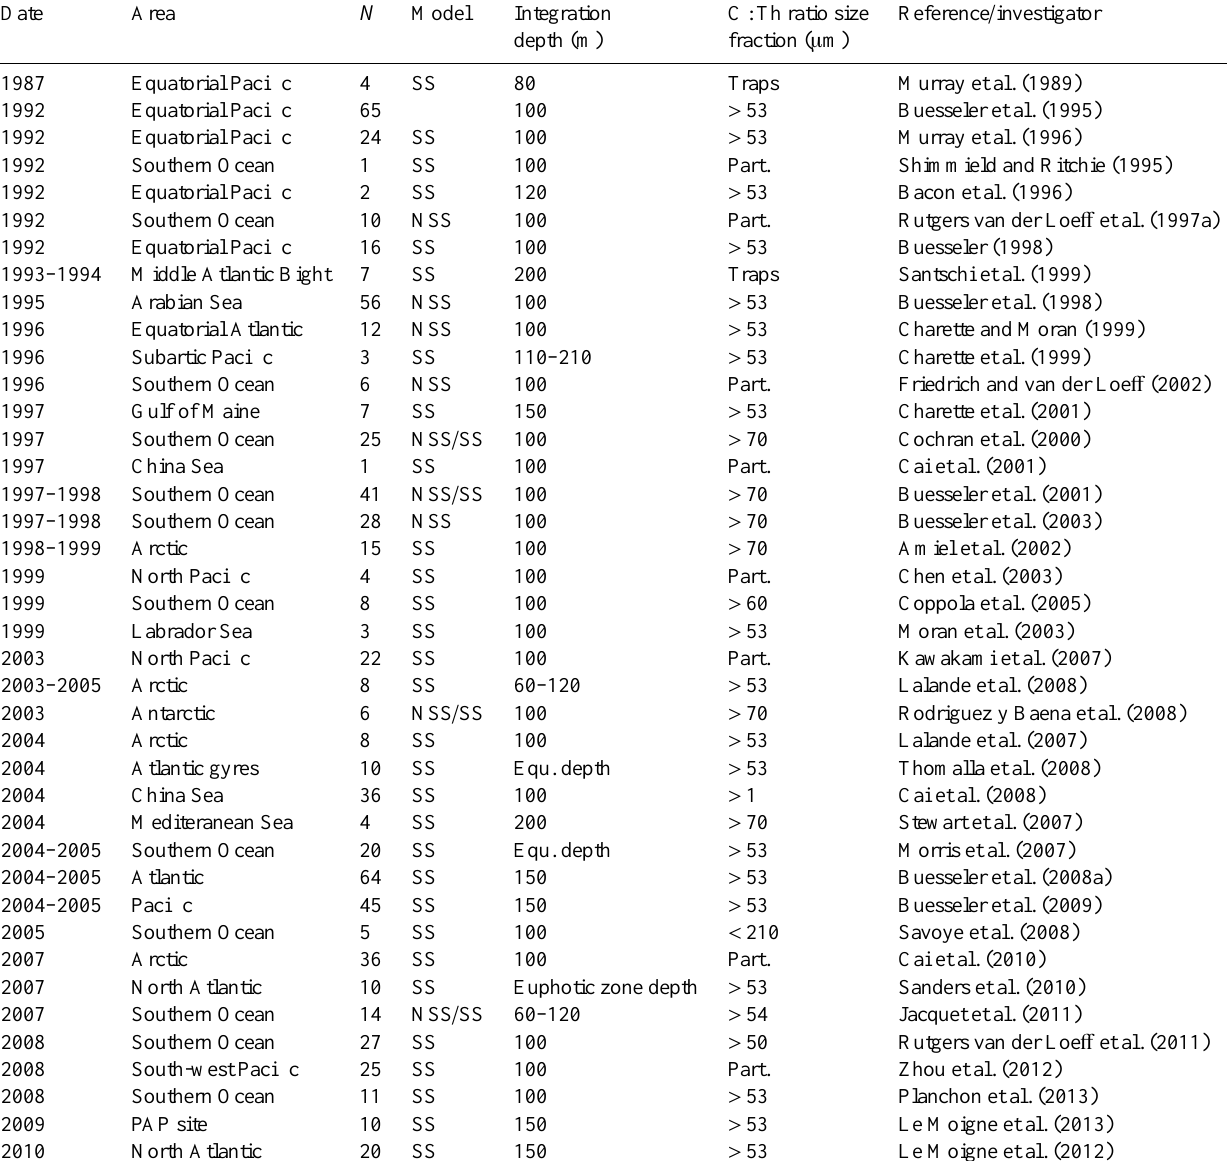
Table 1. Sampling year, area, number of samples ( N ), model used (see text, Sect. 2.1), C:Th size fraction (“Part.” refers to the entire particulate fraction) and reference of studies used in the database. “Traps” is indicated when C:Th ratio were measured in sediment traps and “Equ.” refers to equilibrium